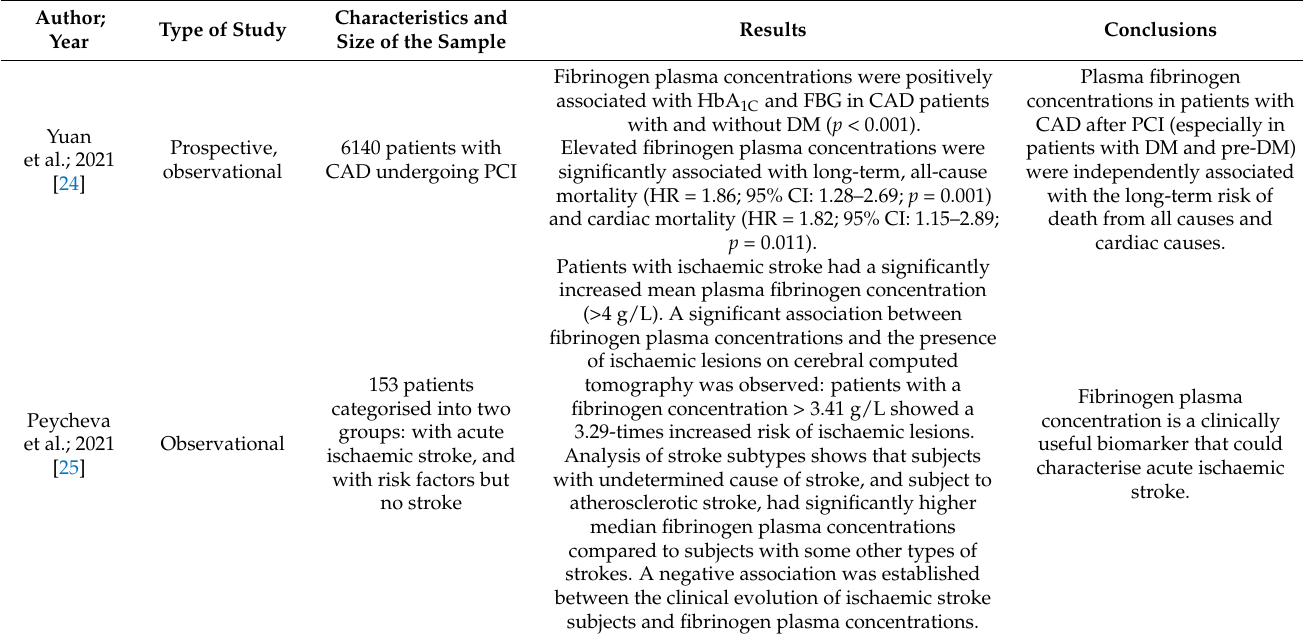
Table 2. Plasma fibrinogen concentration and CVD risk and prognosis in various groups of